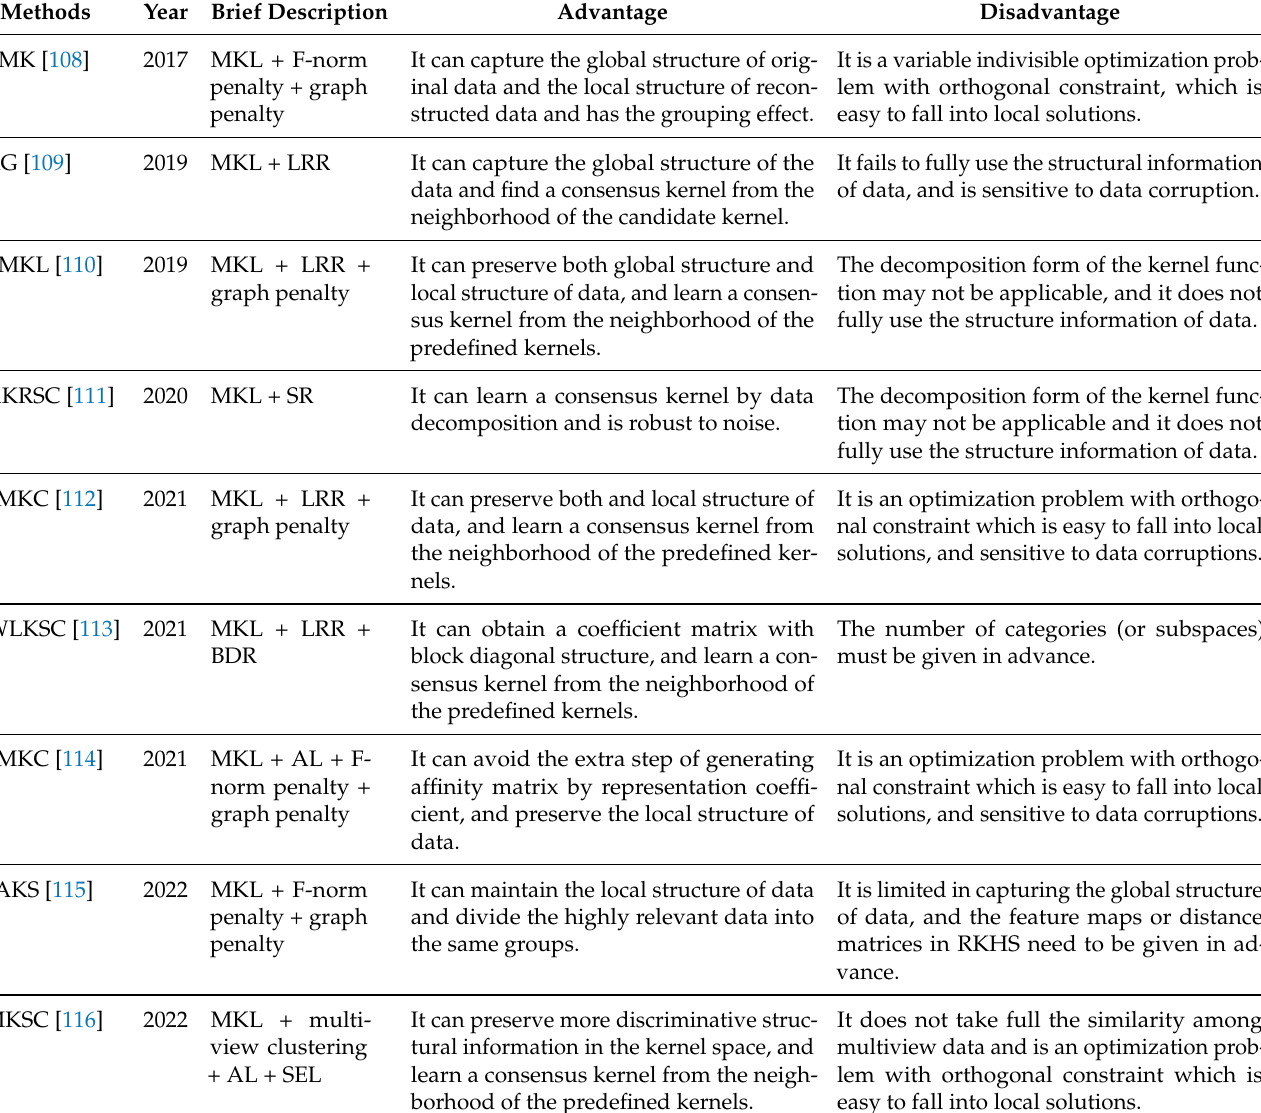
Table 9. The comparison of classical MKL-based SC